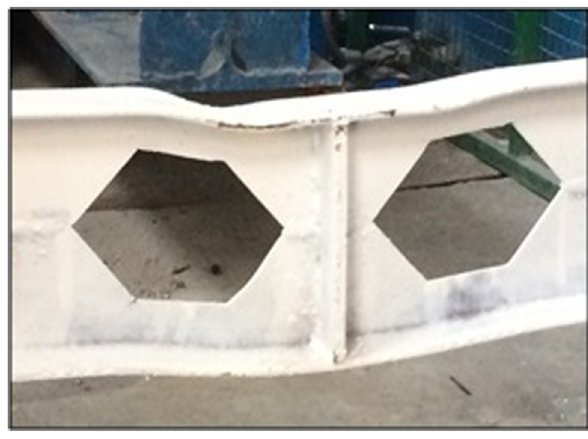
Figure 9: Failure mode of specimen ( CBN - 0 ) .